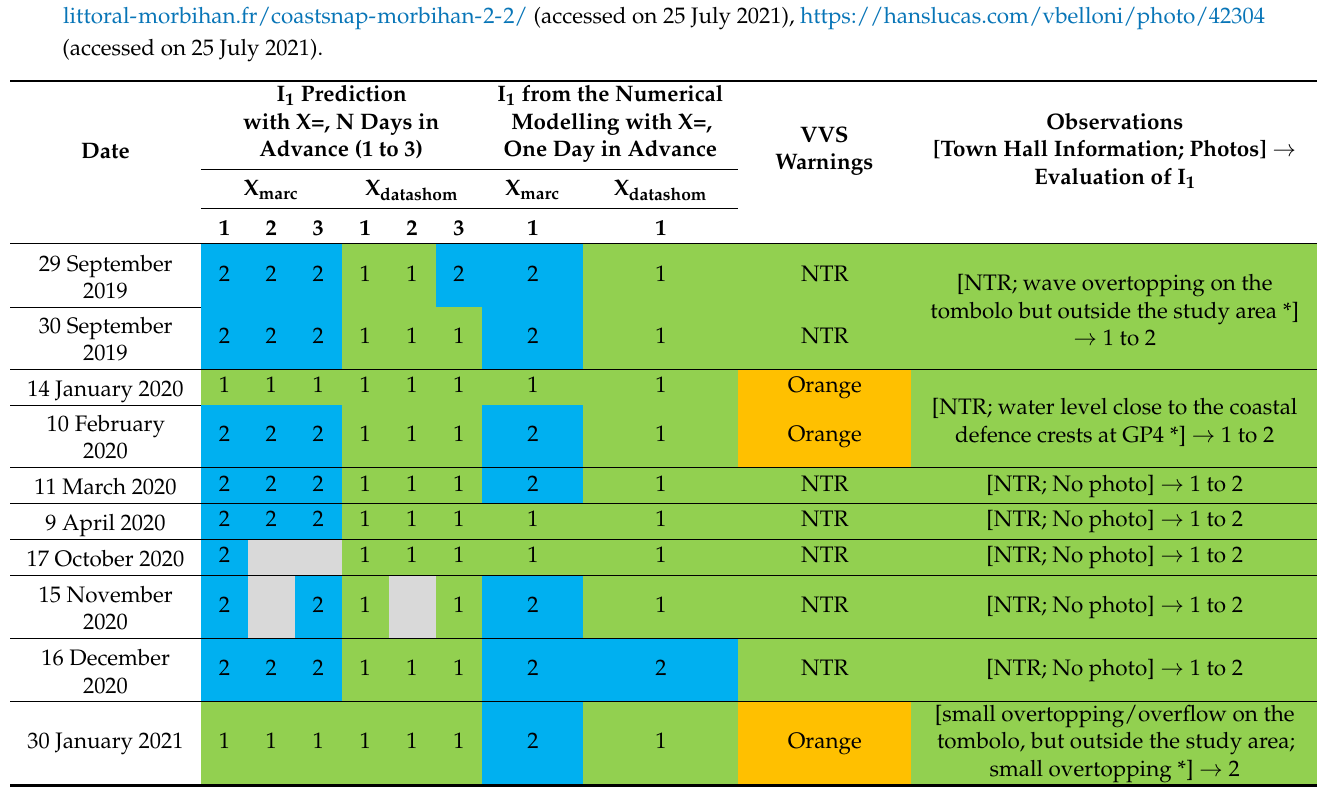
Table 3. C(I 1 ) values (the colour scale is in accordance with Figure 3: green for “nothing to report” and blue for “close to flood”) for the events where either the FEWS predicts C(I 1 ) ≥ 2 or a regional official warning was emitted (VVS) from December 2018 to March 2021. NTR: Nothing to report. *: sources of photos: https://www.ouest-france.fr/bretagne/gavres- 56680/gavres-avec-la-forte-houle-les-engins-ont-du-etre-deplaces-6544164 (accessed on 25 July 2021),